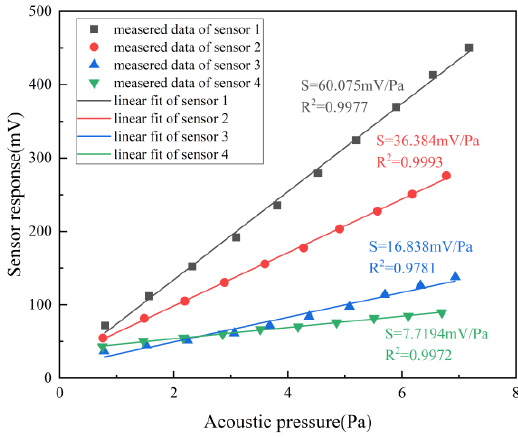
Figure 6. Comparison of the sensitivity of proposed acoustic sensors.